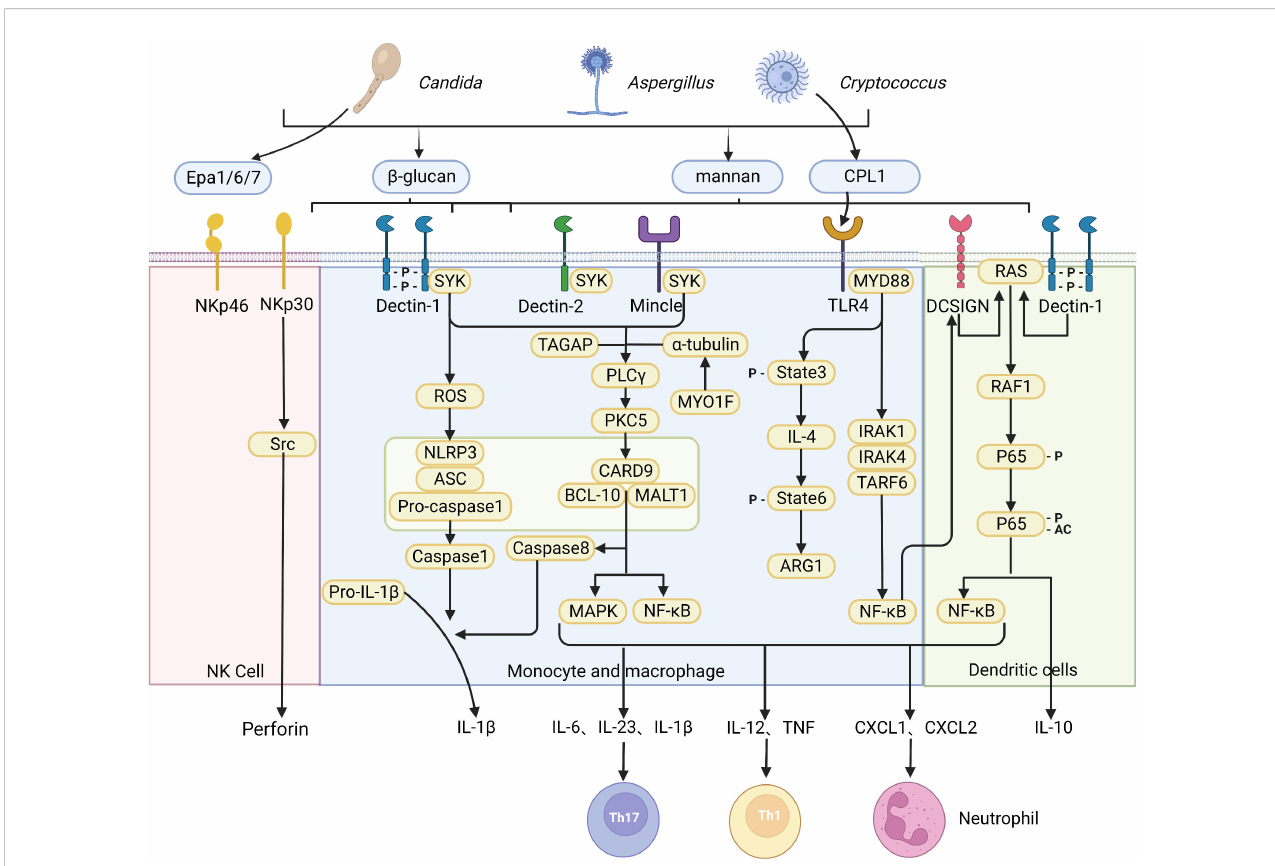
FIGURE 1 Recognition of fungi by pattern recognition receptors. A diagrammatic representation of pattern recognition receptors involved in the recognition of various fungal species, and the cellular responses triggered by ligand-receptor binding. The CLR family of receptors recognize fungal carbohydrates and result in activation of the SYK – CARD9 axis, formation of the CARD9 – BCL10 – MALT1 complex and activating nuclear NF- k B and MAPK signaling pathways, which in turn activate synthesis and release of pro-in fl ammatory cytokines and chemokines including IL-6, IL-1 b , IL-23, IL-12, CXCL1 and CXCL2. The release of chemokines and cytokines that promote CD4 + T cell differentiation into speci fi c T helper cell. The NOD-like receptor NLRP3 forms in fl ammasome complex with ASC and caspase-1 that results in production of IL-1 b . In addition, dectin-1 signaling engages the CARD9 – BCL10 – MALT1 complex to promote non-canonical in fl ammasome activation that results in IL-1 b production via caspase-8. In contrast, NK cells equipment with receptor NKp30 and NKp46 as a microbial pattern-recognition receptor to recognize fungi. C-type lectin DC-SIGN modulates TLR signaling via Raf-1 kinase-dependent acetylation of NF- k B in DCs. (Created with